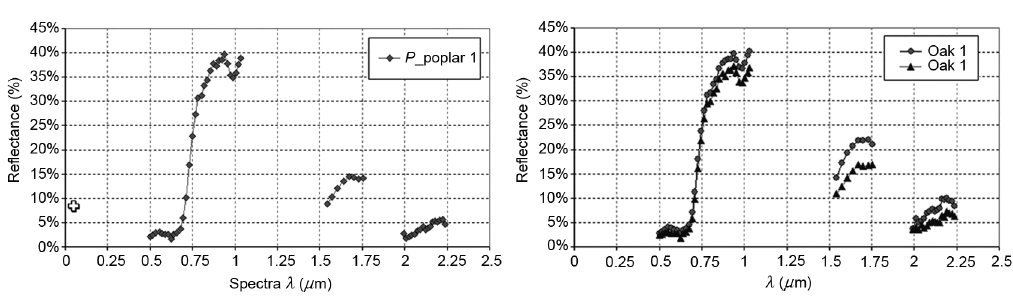
Fig. 2. Examples of spectral endmembers selected by correlation analysis conducted on 20 DAIS spectra. Im- age location was defined with the help of GPS measurements and visual interpretation of false colour